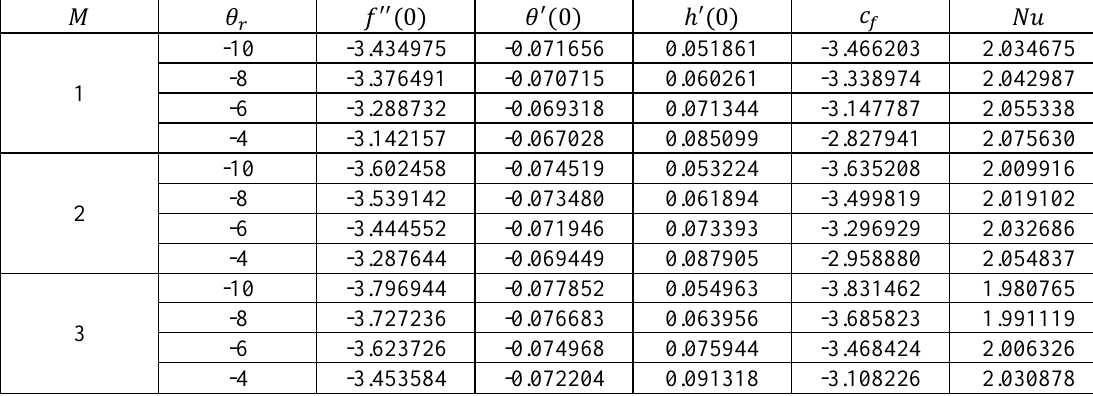
Table 2. Missing values and physical quantities for different values of 𝑀 and 𝜃